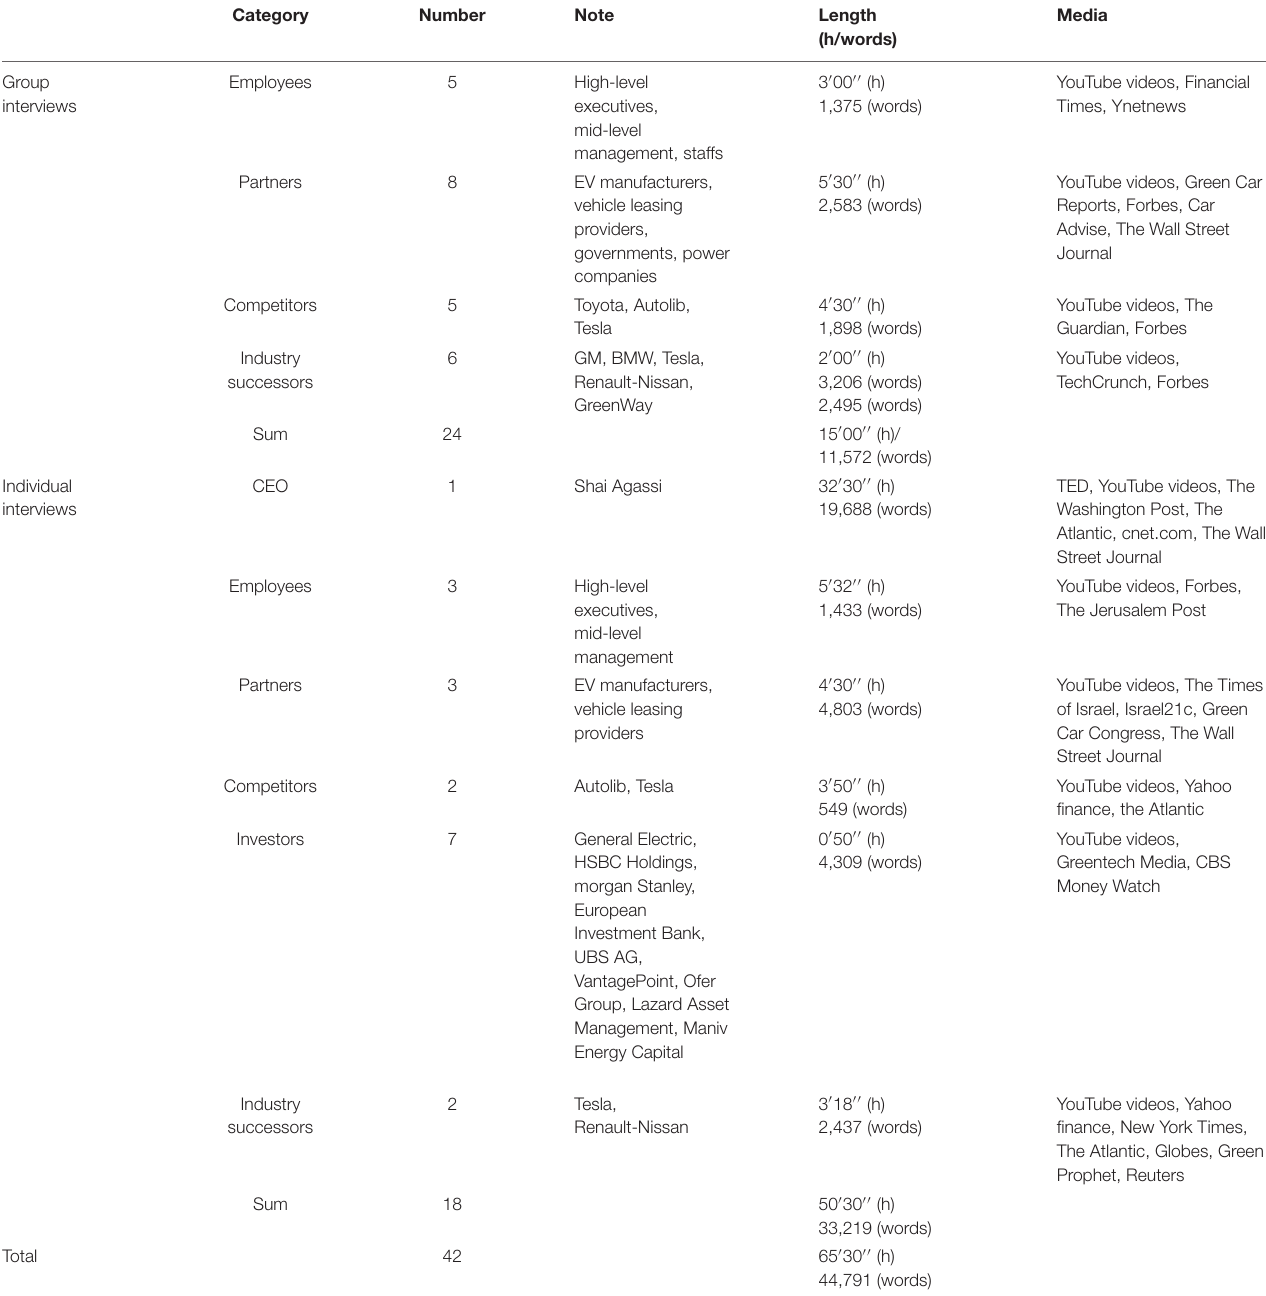
TABLE 1 | Categories of identities of the persons interviewed by media